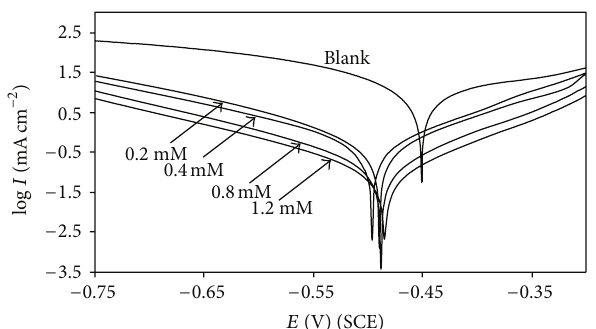
Figure 5: Polarisation curves for C38 steel in 1M HCl containing different concentrations of harmane at 45 ∘ C.